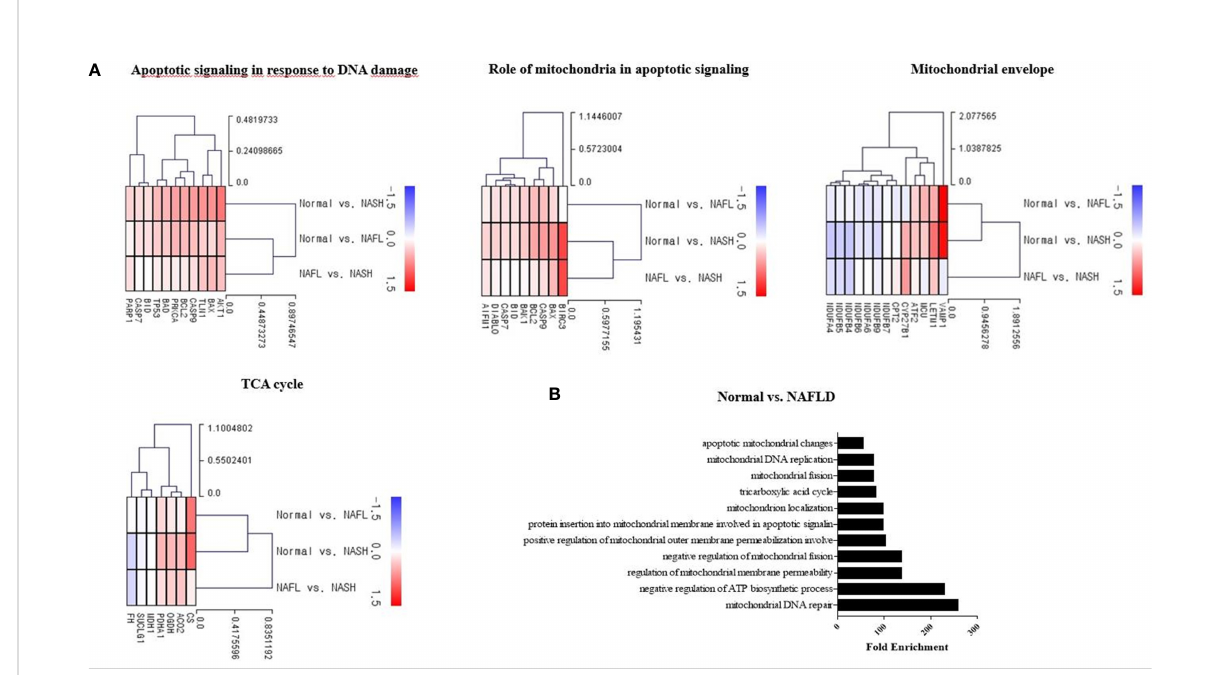
FIGURE 1 Mitochondria-associated transcriptome analysis in NAFLD. (A) Heatmap showing the gene-expression difference in three groups (control, NAFL, and NASH). RNA sequencing was analyzed by the Multiple Experiment Viewer. (B) Gene enrichment analysis for DEGs was performed using the Gene Ontology (GO) databases. Functional enrichment analysis based on each module of interest was completed within DAVID, including the